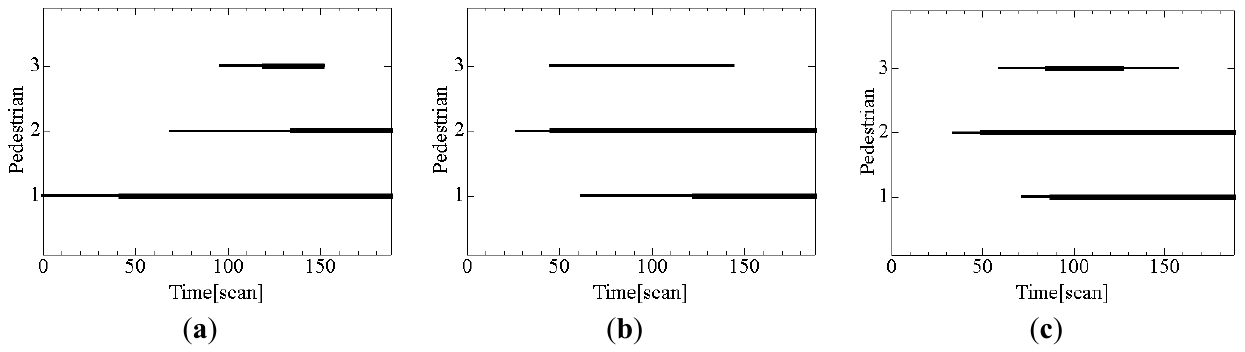
Figure 14. Duration of individual and cooperative tracking. The thin line indicates the time during which the pedestrian exits the sensing area of each robot. The bold line indicates the time during which the robot tracks pedestrians using the individual and cooperative